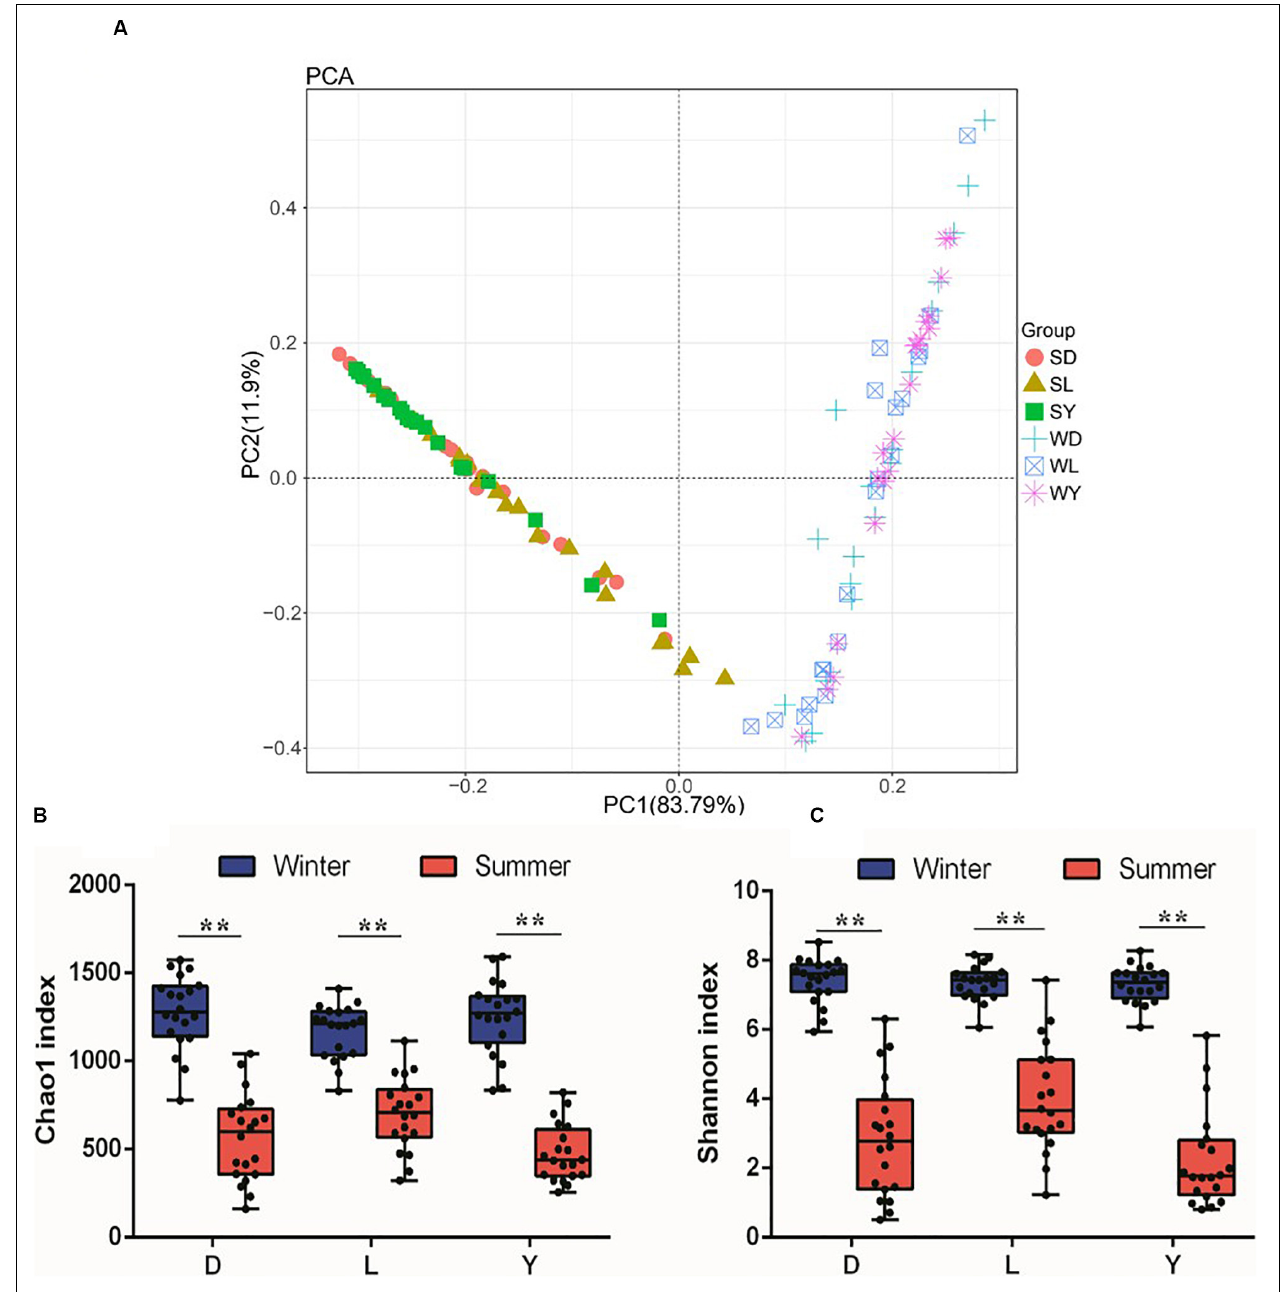
FIGURE 3 | PCA analysis and diversity of semen microbiota in different breed of boars between winter and summer. (A) PCA plot. Each symbol represents 1 boar, SD, samples collected from Duroc in summer; SL, samples collected from Landrace in summer; SY, samples collected from Yorkshire in summer; WD, samples collected from Duroc in winter; WL, samples collected from Landrace in winter; WY, samples collected from Yorkshire in winter. (B) Chao1 richness index, and (C) Shannon diversity index. D, Duroc; L, Landrace; Y, Yorkshire. ** P <